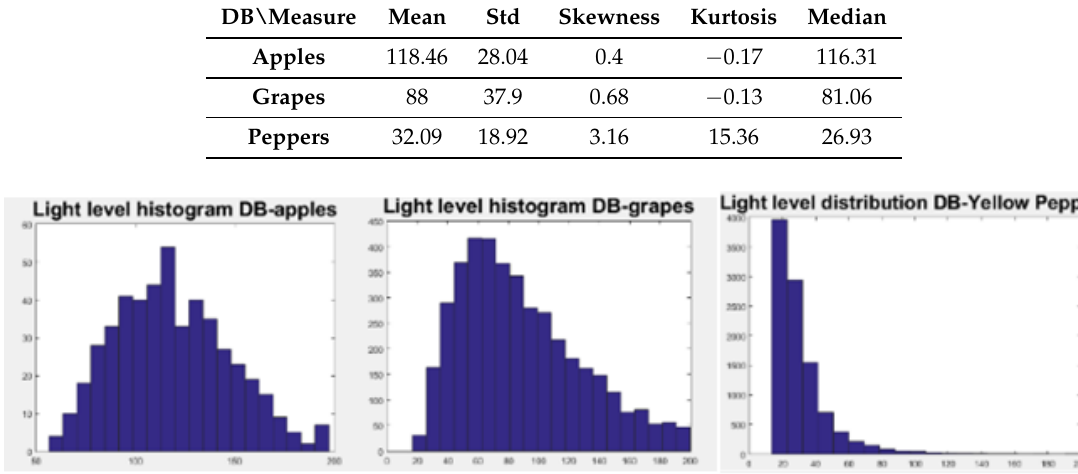
Figure 12. Light level distribution computed for each